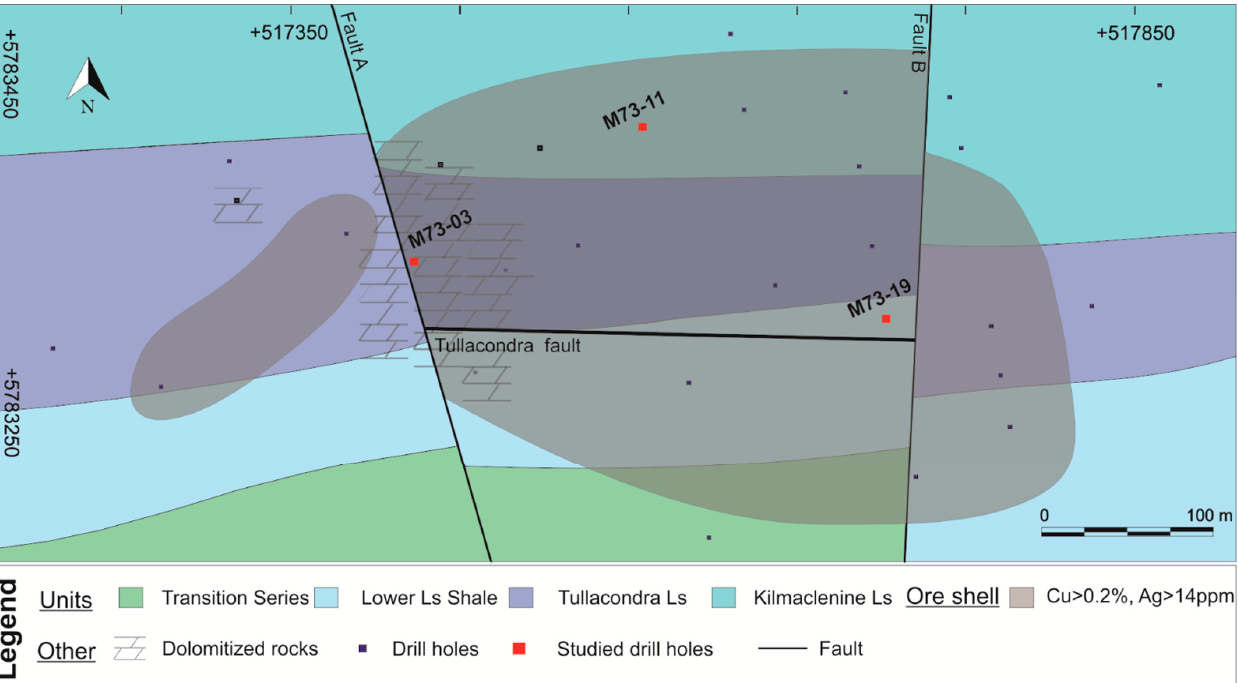
Figure 3. Local geological map of the Tullacondra deposit based on legacy data from drill hole logs and its main structural features (the Tullacondra, A, and B faults). The ore shell is represented in gray and corresponds to the mineralized zones with Cu > 0.2% and Ag >14 ppm to reflect natural breaks in grade values. Note the dolomitized area is roughly coincident with Fault